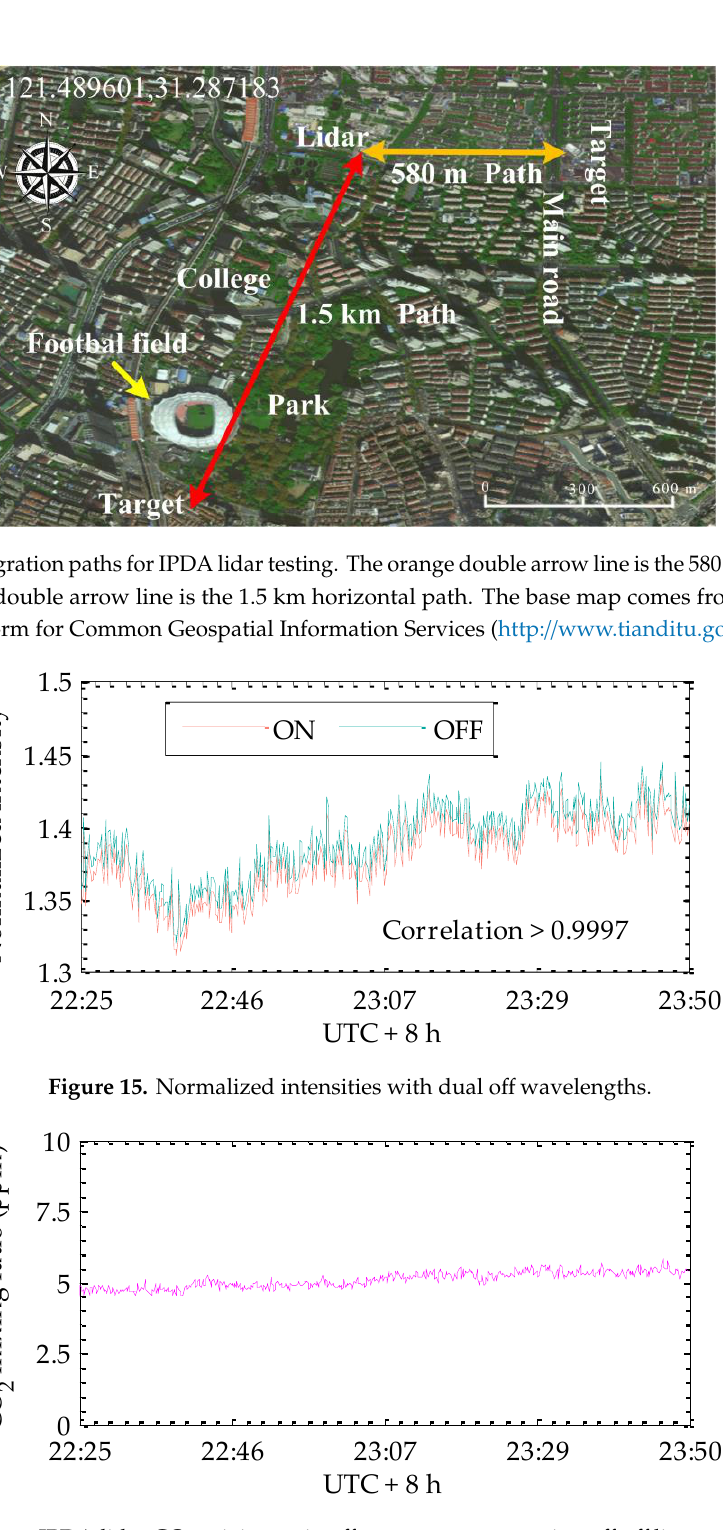
Figure 17. Simultaneous measurements of the diurnal variations of atmospheric CO 2 with the improved IPDA lidar system and an in situ sensor. Black boxes indicate rainy weather. The integral path length is 580 m.